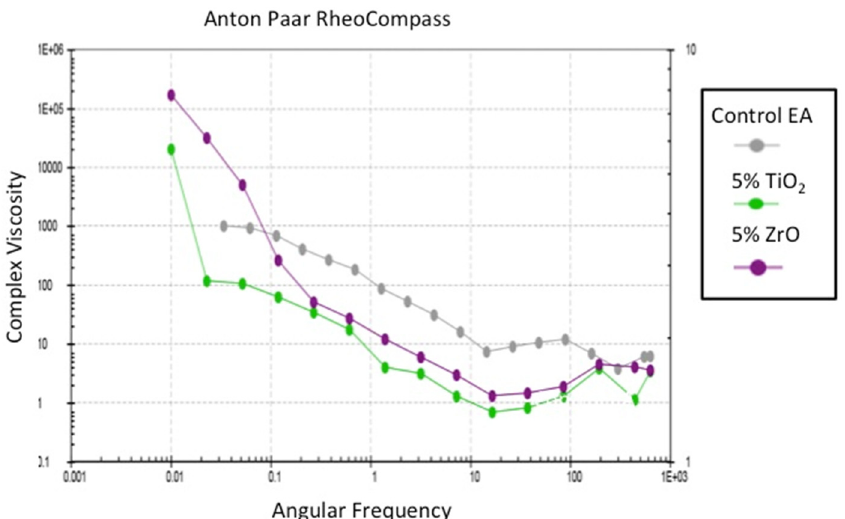
Figure 3. Rheological properties of the experimental control (Control EA), 5%-TiO 2 , and 5% ZrO 2 adhesives. Complex viscosity is shown for angular frequencies of 0.001 to 1000 rads/s.